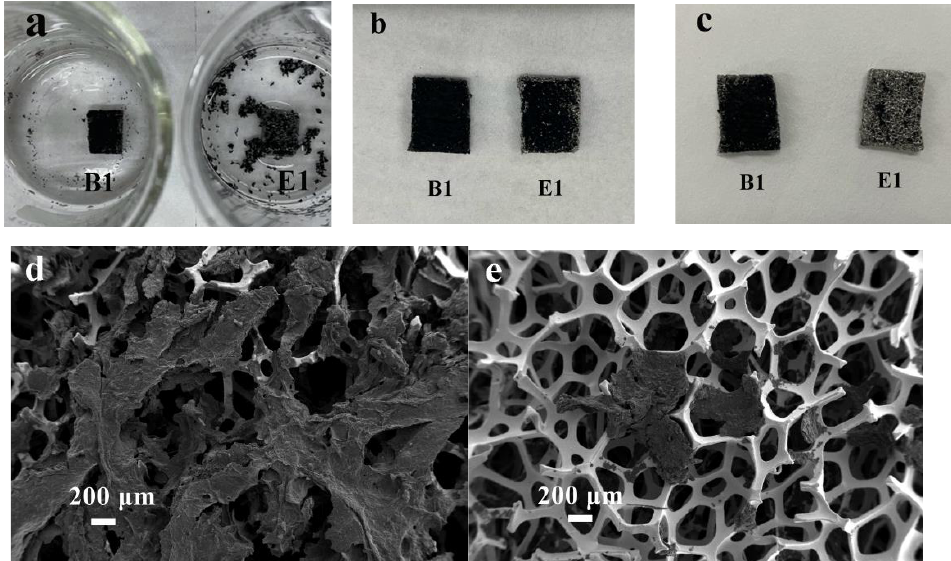
Figure 5. Digital pictures of B1 sheet (1 cm × 1.2 cm) and E1 sheet (1 cm × 1.2 cm) ( b ) before and ( a , c ) after ultrasonic treatment in ethanol and water mixed solution; SEM images of B1 ( d ) and E1 ( e ) after ultrasonic treatment.